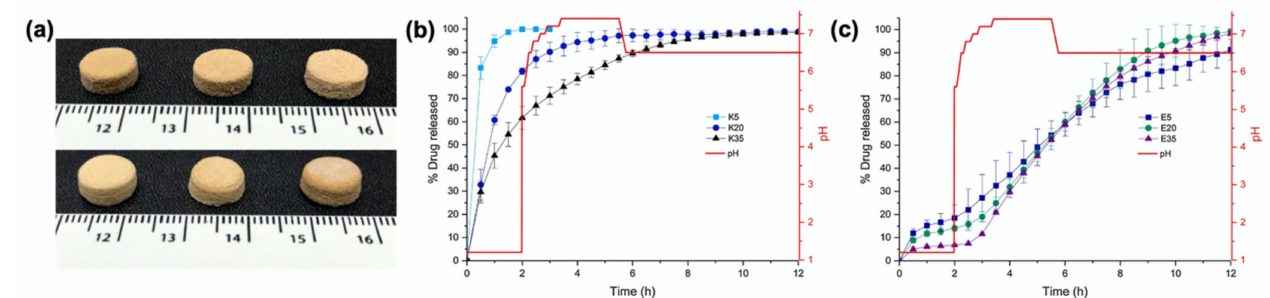
Figure 5. ( a ) SLS-printed paracetamol tablets with different drug loadings (5, 20, 35 and wt%, from left to right). Tablets in the top raw were printed with Kollicoat IR and tablets in the bottom row are printed with Eudragit L100-55; ( b ) drug release profile from tablets printed with Kollicoat IR; ( c ) drug release profile from tablets printed with Eudragit L100-55. Adapted with permission from Reference [109]. Copyright 2017,